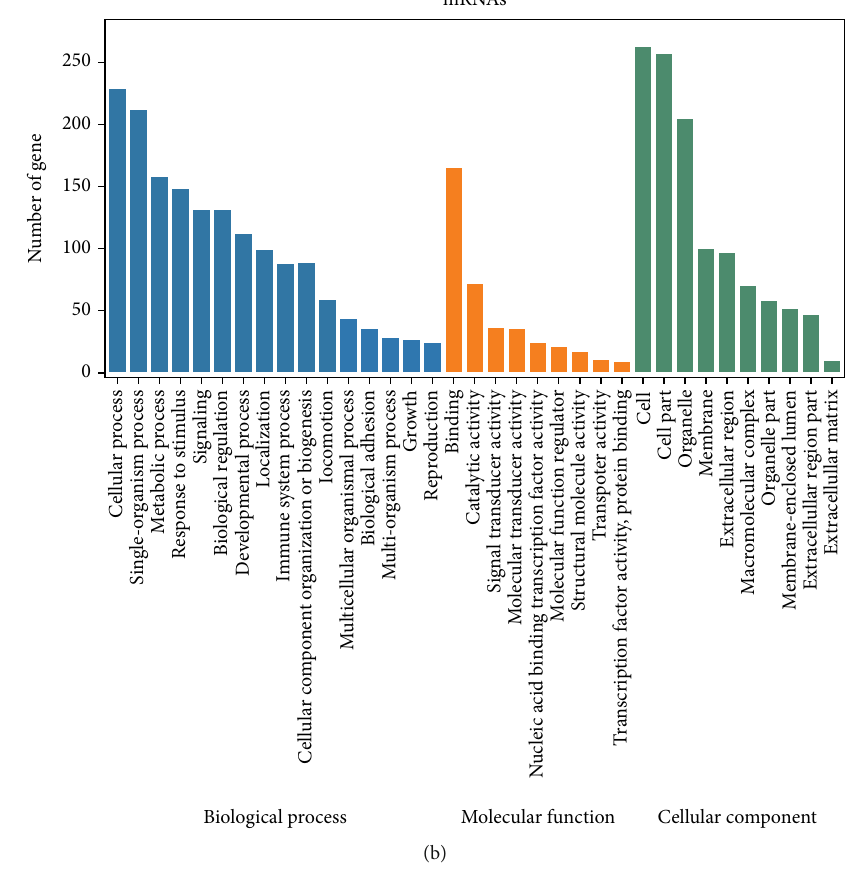
Figure 4: Bioinformatics analysis of T1D-lncRNA and T1D-mRNA. Gene Ontology analysis of T1D-lncRNAs (a) and T1D-mRNAs (b) in biological processes, molecular functions, and cellular